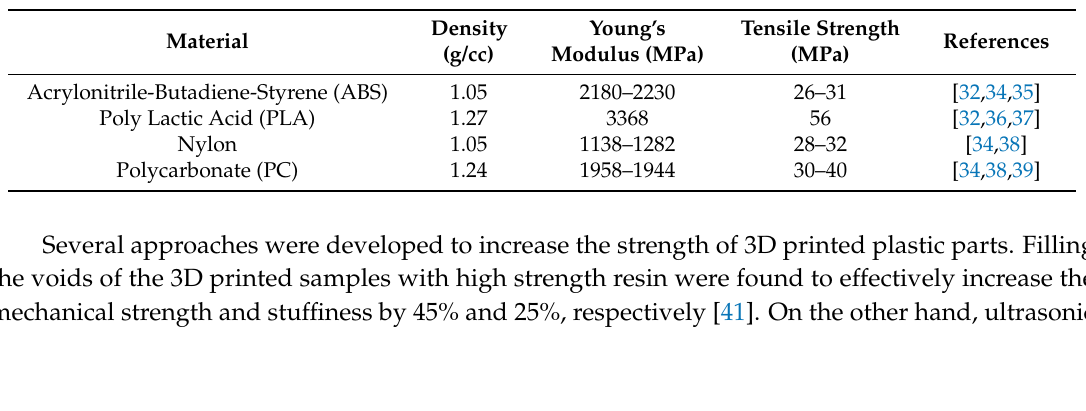
Table 1. The most common fused deposition modelling (FDM)